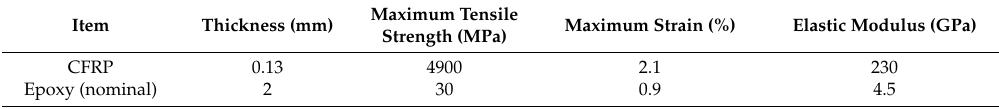
Table 3. Carbon fiber-reinforced polymer (CFRP) and adhesive properties